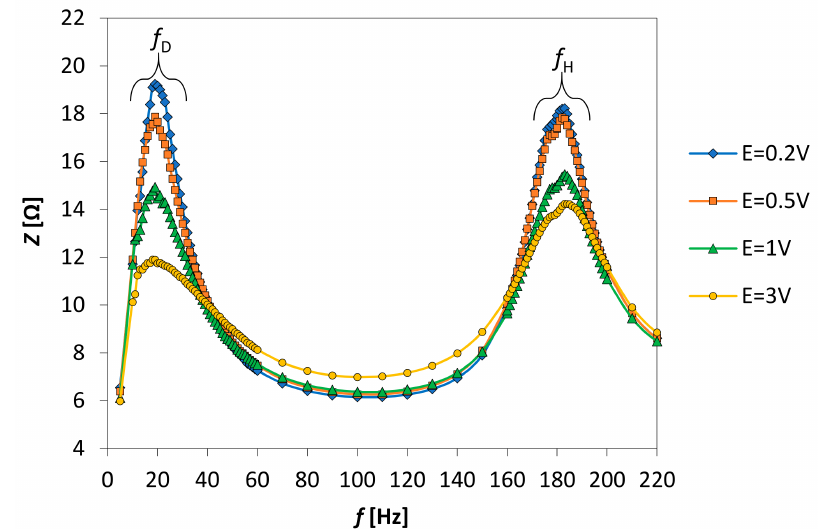
Figure 7. Effect of SJA supply voltage on the frequency of resonances.